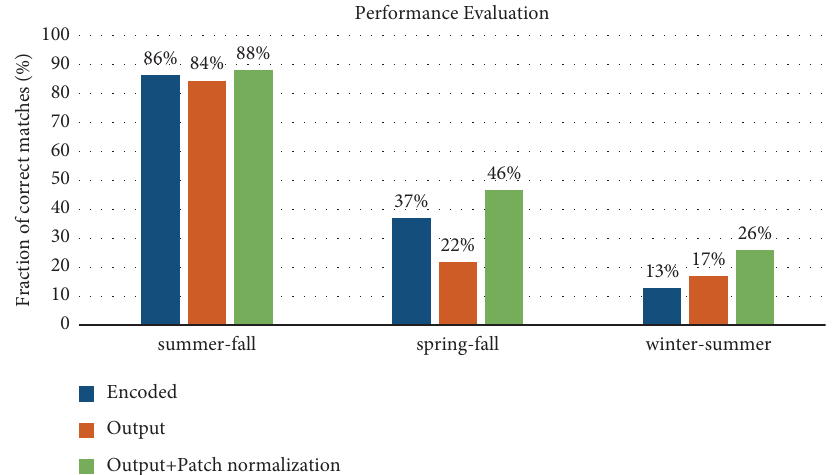
Figure 19: Tis result is obtained using the fundamental auto-encoder.